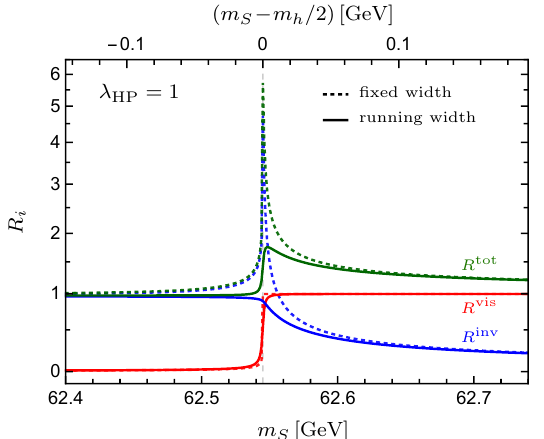
(dashed lines) and R r (cid:25) (cid:27) r (solid lines) using a (cid:27) h ( m 2 ) (cid:27) h ( m 2 ) h h